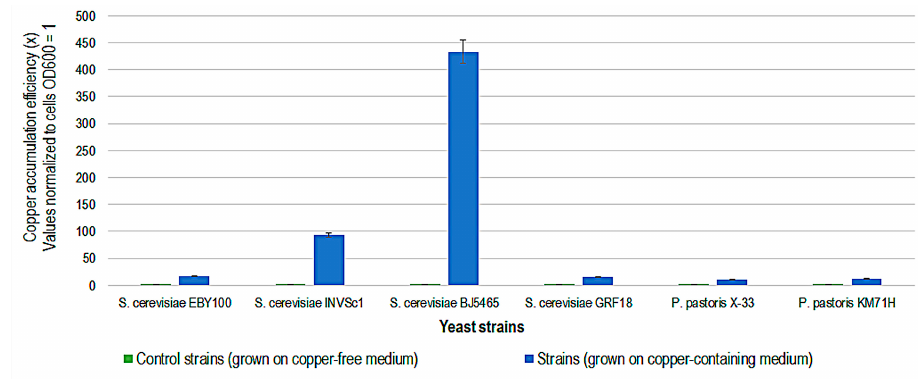
Figure 7. Copper accumulation efficiency (x) of different yeast strains after 48 h of incubation at 30 °C, in copper-containing Yeast-Peptone-Dextrose medium. Control strains were grown in a copper-free medium.